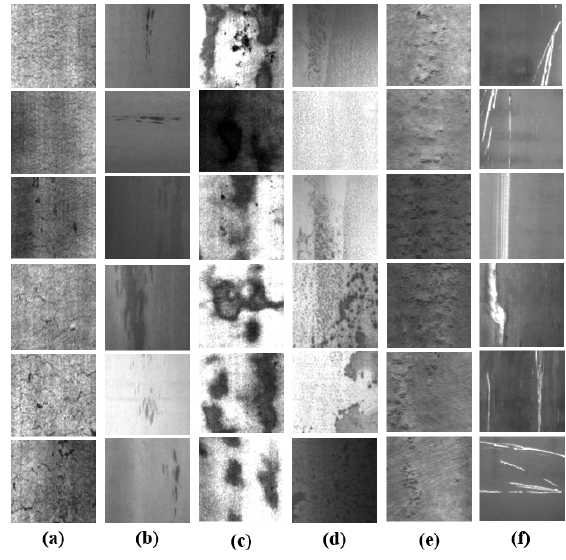
Figure 1. Examples for the six kinds of defect classes of the Northeastern University surface defect database (NEU) [2]: ( a ) crazing (Cr), ( b ) inclusion (In), ( c ) patches (Pa), ( d ) pitted surface (Ps), ( e ) rolled-in scale (Rs), ( f ) scratches (Sc).